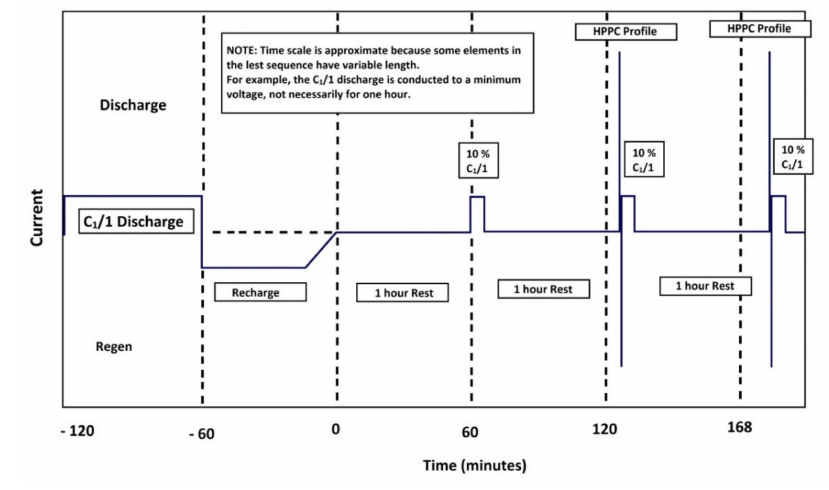
Figure 23. HPPC test sequences [23].